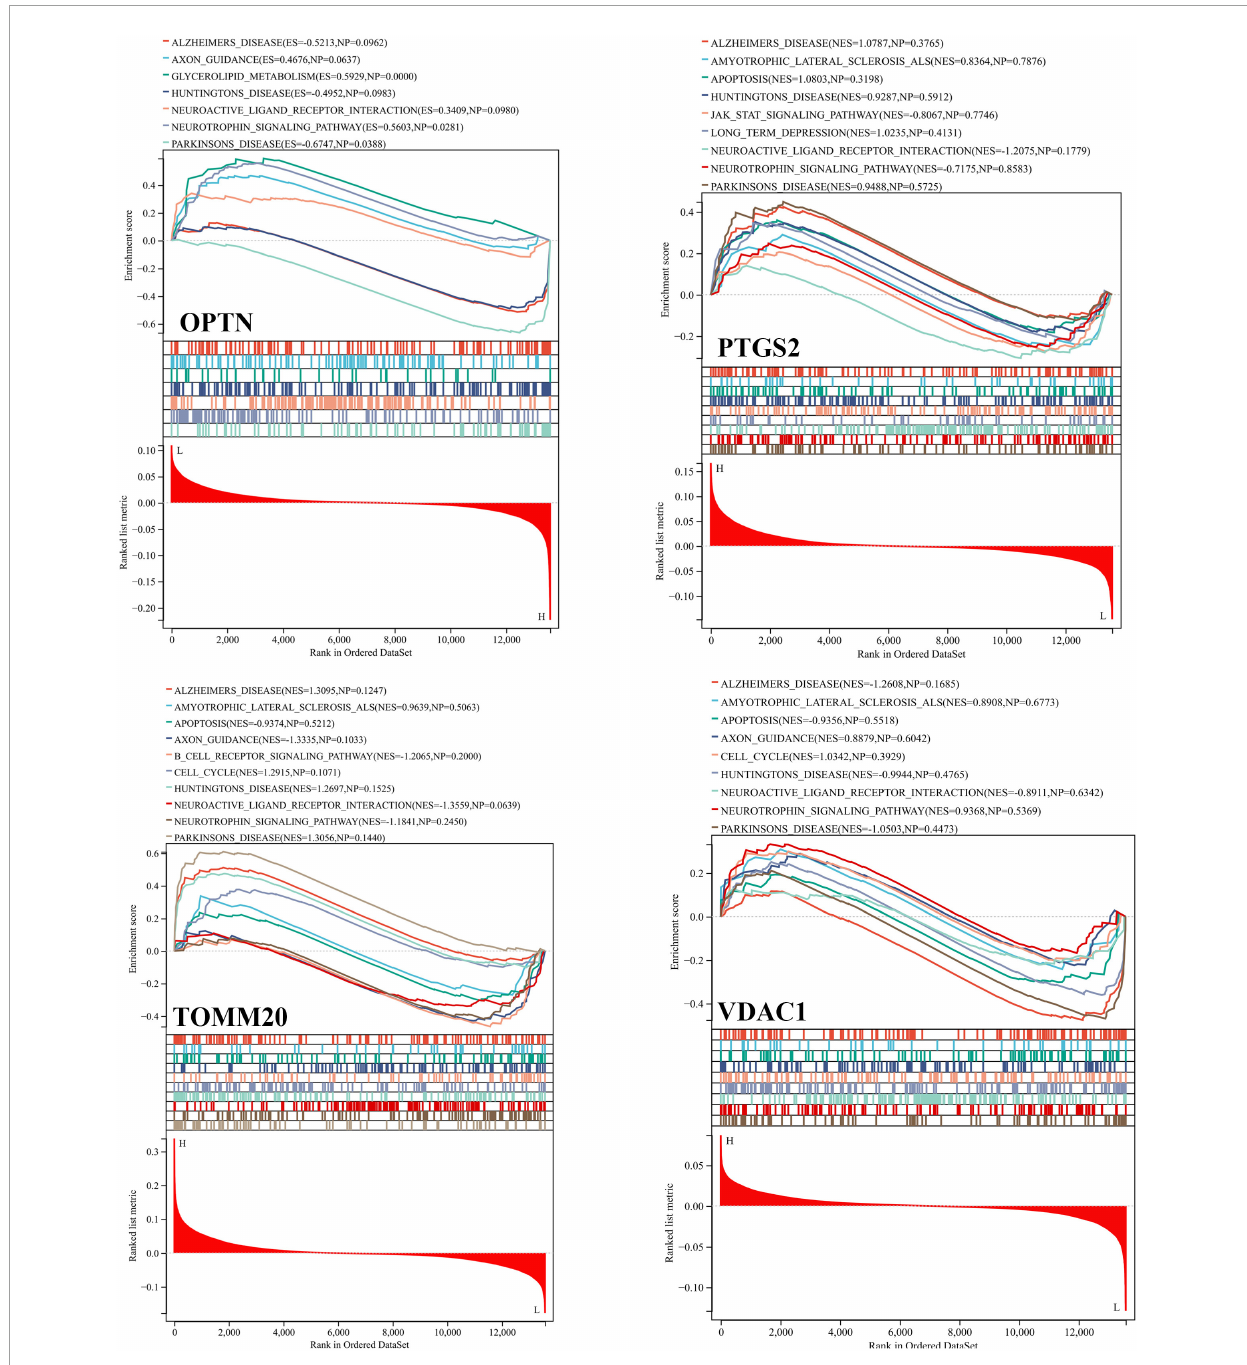
FIGURE8 Gene set enrichment analysis (GSEA) of OPTN, PTGS2, TOMM20, and VDAC1 genes using KEGG gene sets.